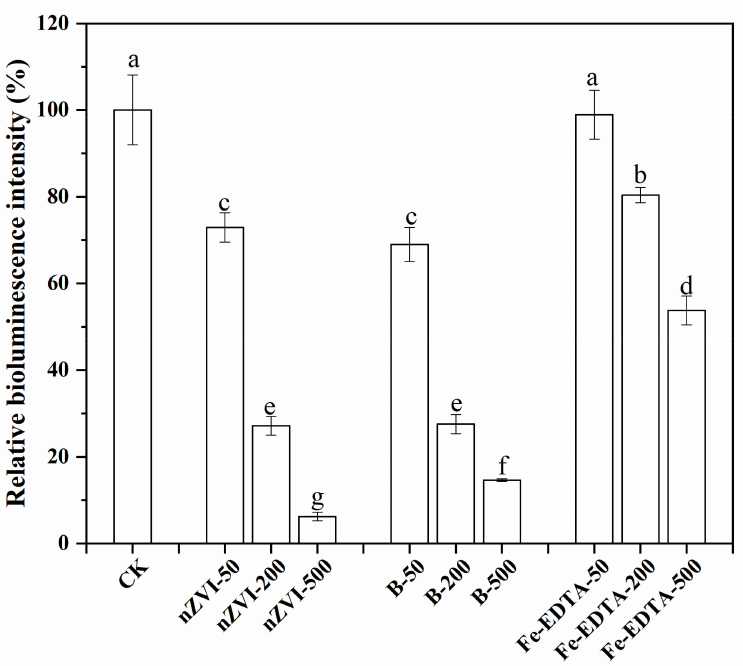
Figure 6. The relative bioluminescence intensity of different treatment groups. Error bars indicate the standard deviation of the mean (n = 3). Lowercase letters (a - f) represent significant differences among the different treatments determined by the Fisher least significant difference (LSD) test ( p <